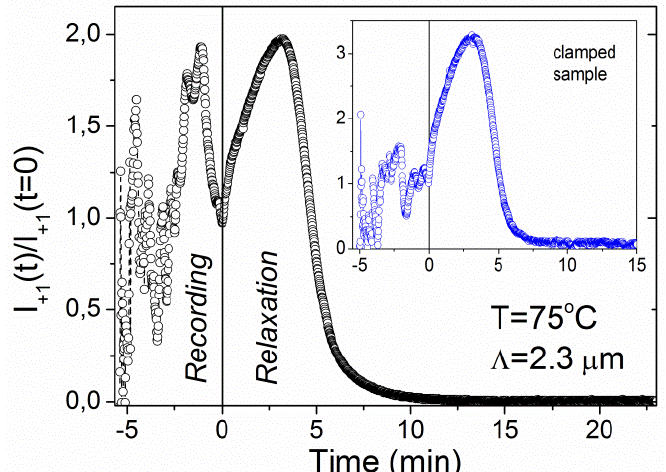
Figure 5. Time dependence of the diffracted intensity during recording and relaxation of the grating with Λ = 2.3 μ m at T = 75 ° C. The inset shows a result obtained for the clamped sample (stretched 5% with respect to the initial